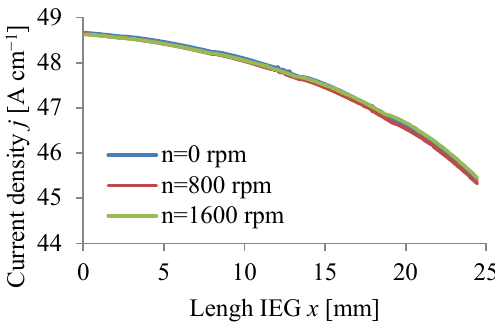
Figure 11. Current density distribution 𝑗 .